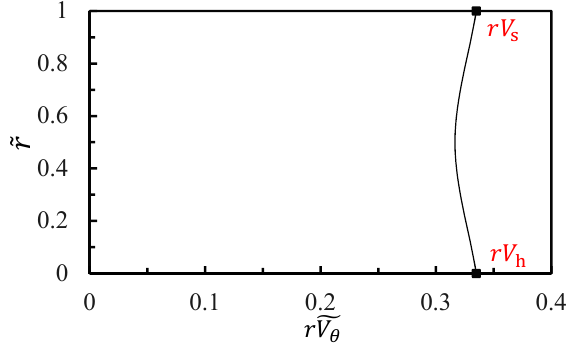
Figure 5. Circulation distribution at the impeller outlet and diffuser inlet.